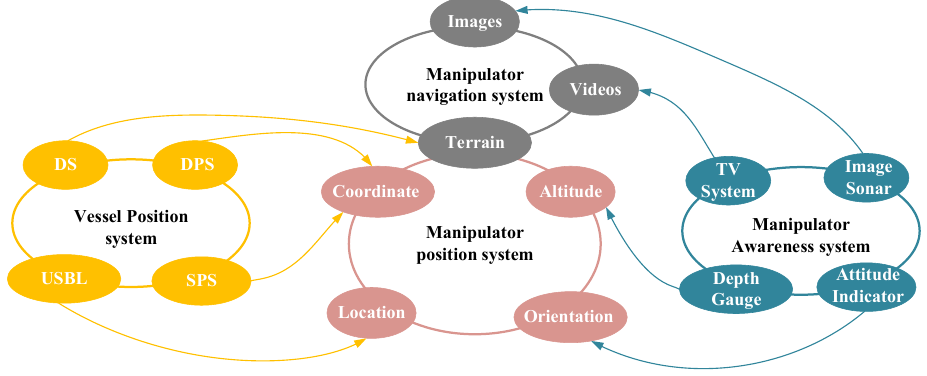
Figure 9. Awareness system and positioning and navigation system.